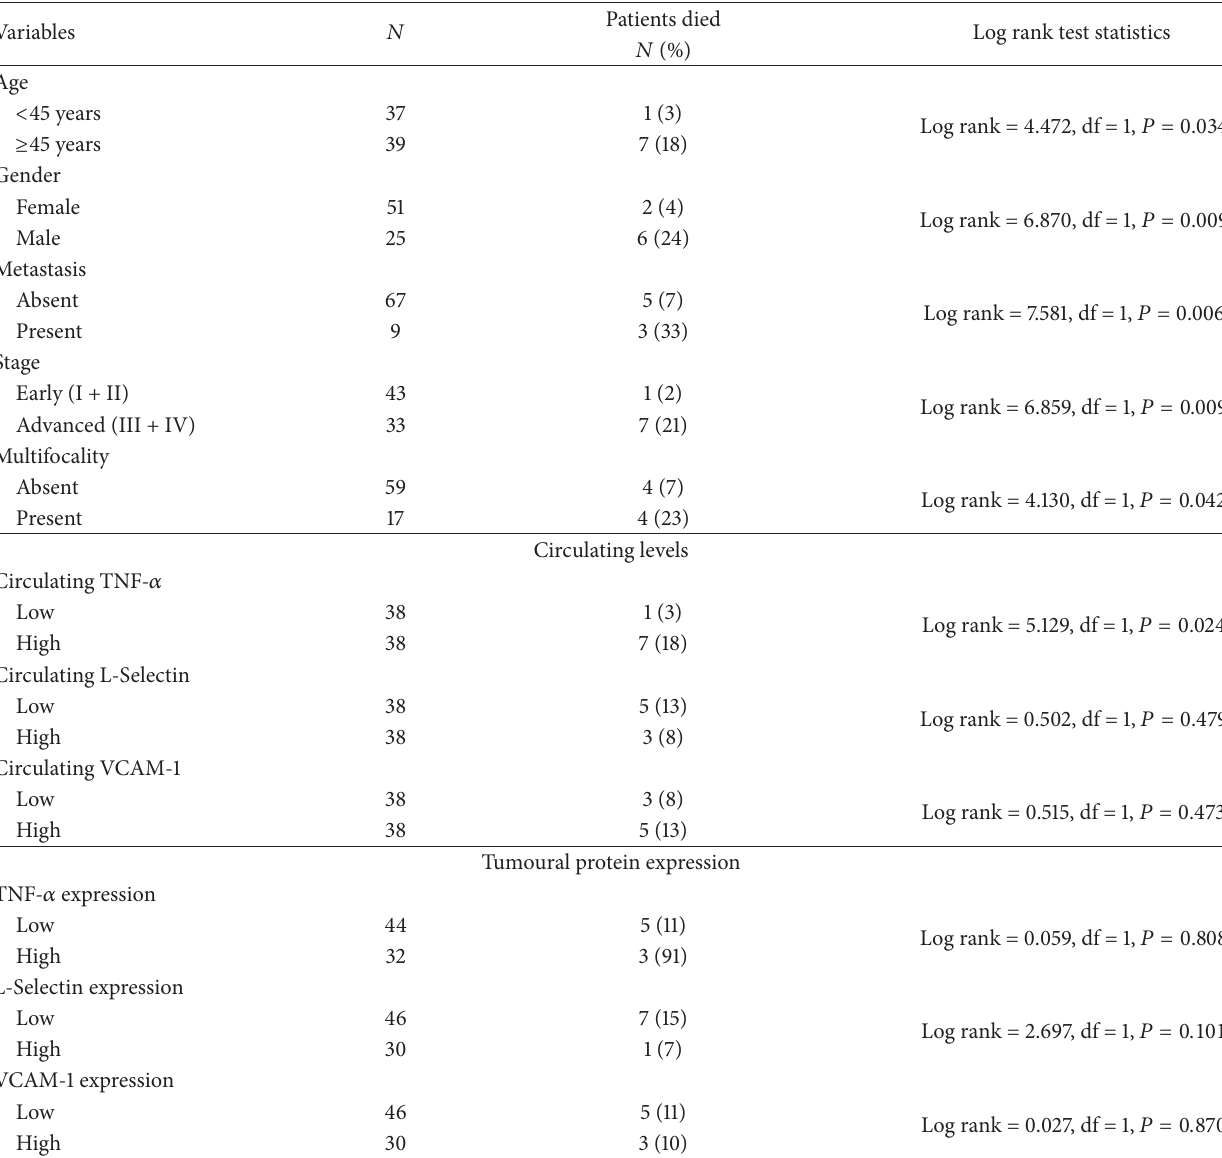
Table 8: Univariate survival analysis for OS in PTC patients ( 𝑁 = 69